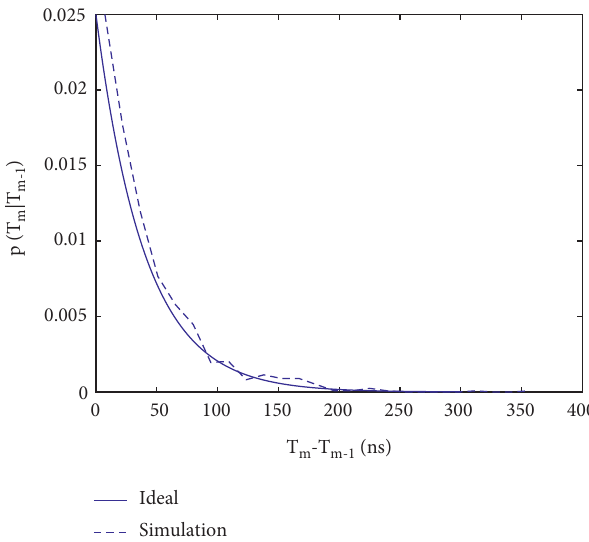
Figure 8: Time distribution of path arrival in the S–V